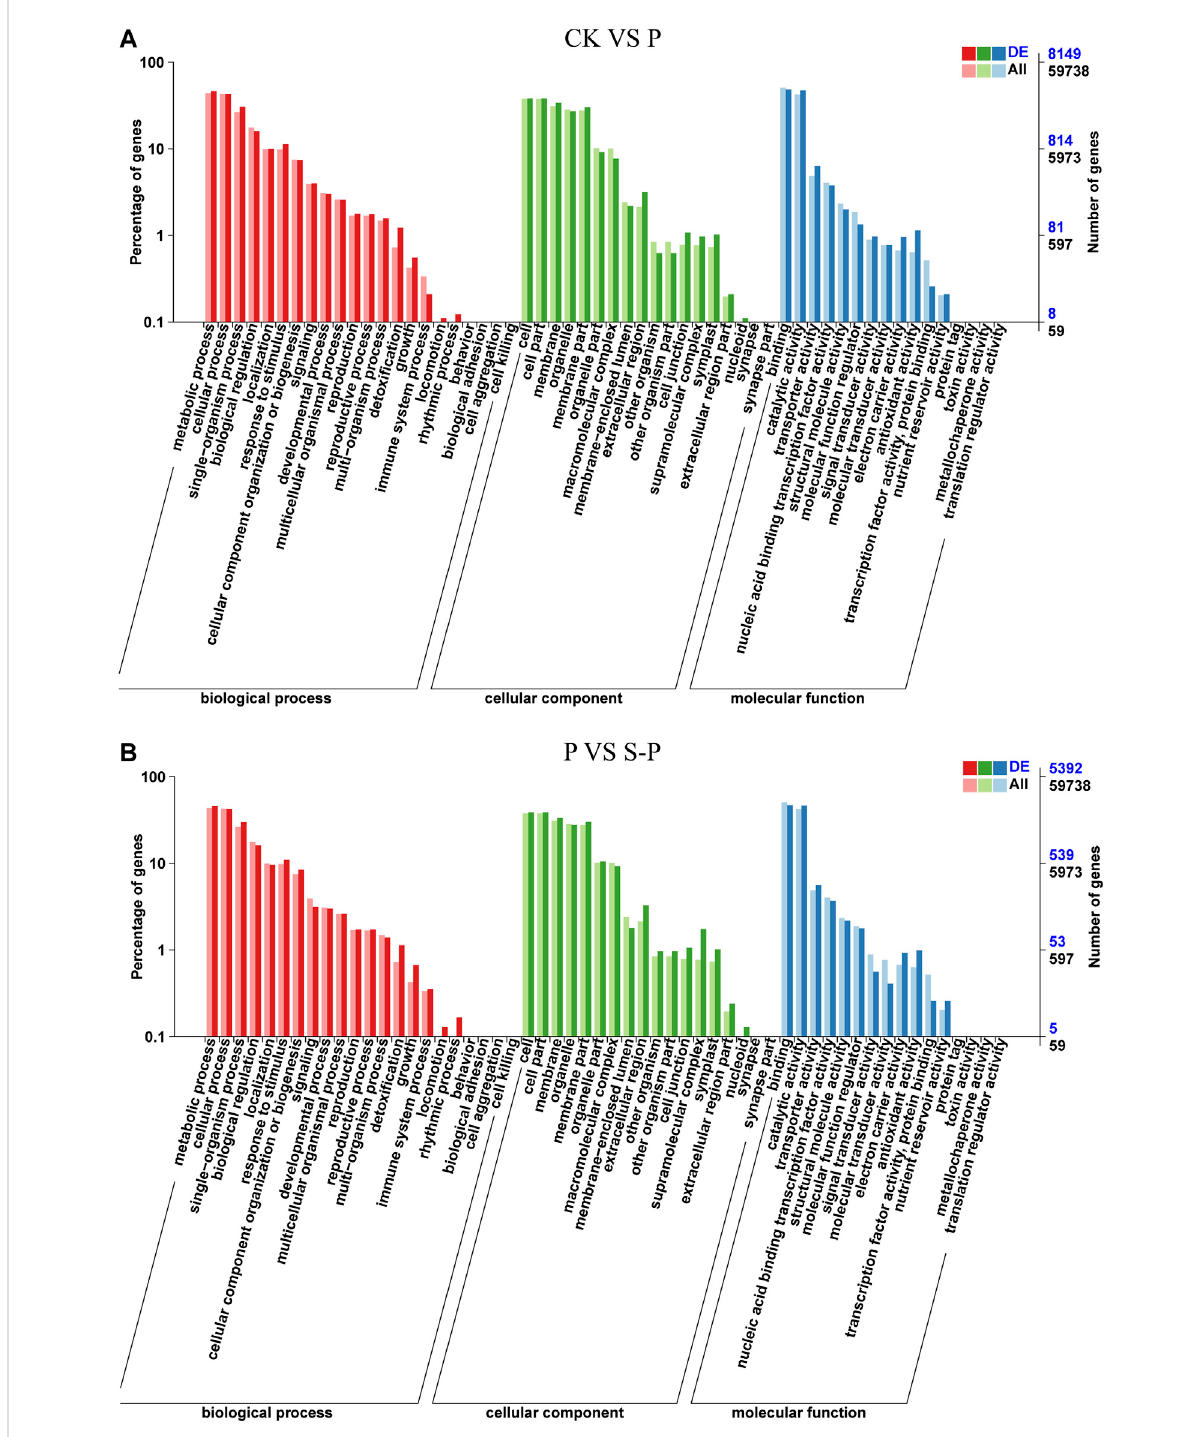
FIGURE 4 Summary of Gene Ontology (GO) categories of the DEGs in CK VS. P (A) and P VS. S-P (B) . CK: blank control; P, PEG stress treatment; S-P, PEG stress group after NaCl